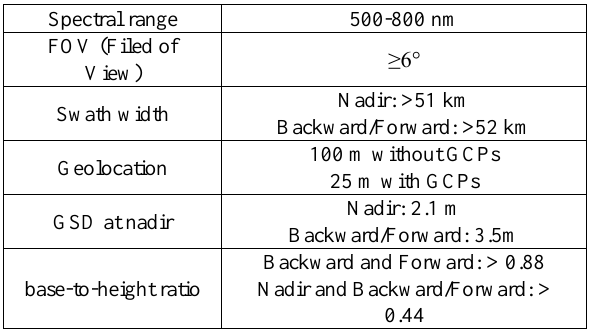
Table 2. Main characteristics of the panchromatic